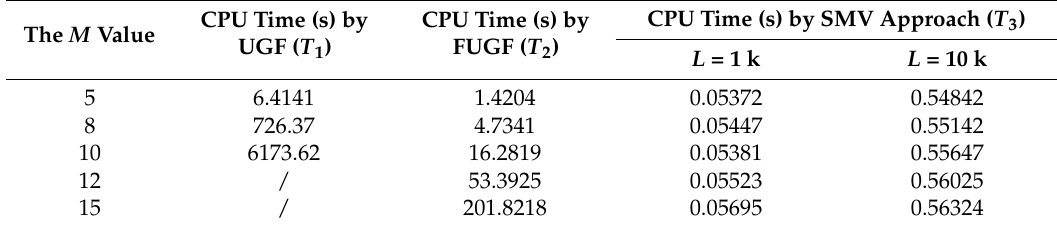
Table 2. Efficiency comparison for a system of model I with 12 components.